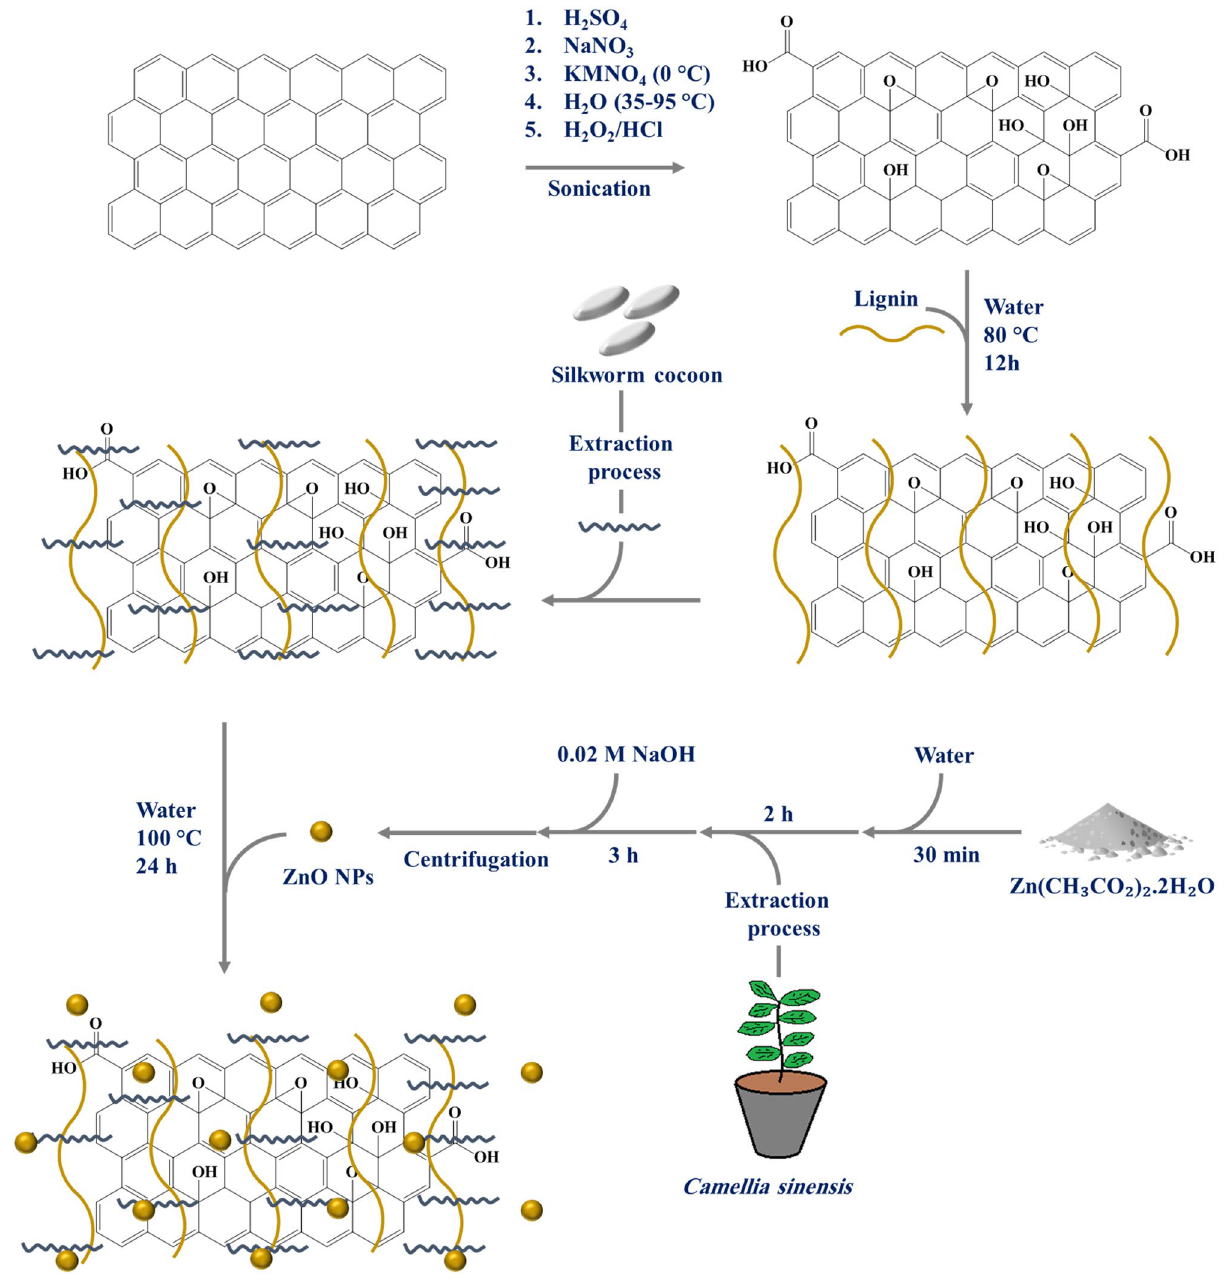
Figure 1. Graphical representation of Graphene oxide-lignin/silk fibroin/ZnO nanobiocomposite synthesis